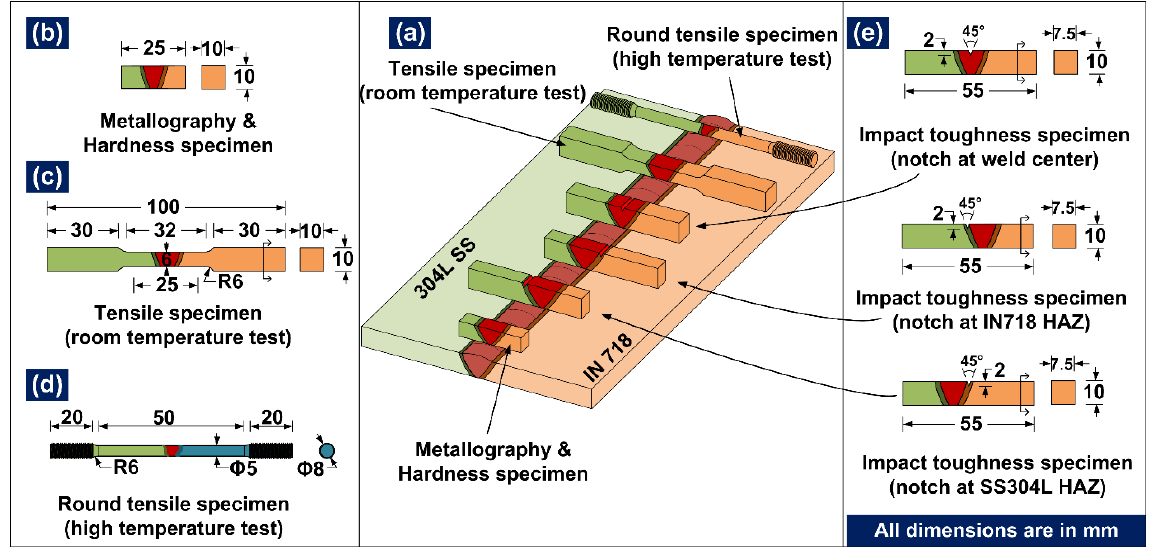
Figure 3. ( a ) Schematic showing the extraction of test coupons from a welded plate, ( b ) test coupon for metallographic study, ( c ) test coupon of room-temperature tensile test, ( d ) test coupon for high- temperature tensile test, ( e ) test coupons for Charpy impact testing of weld metal and HAZ.